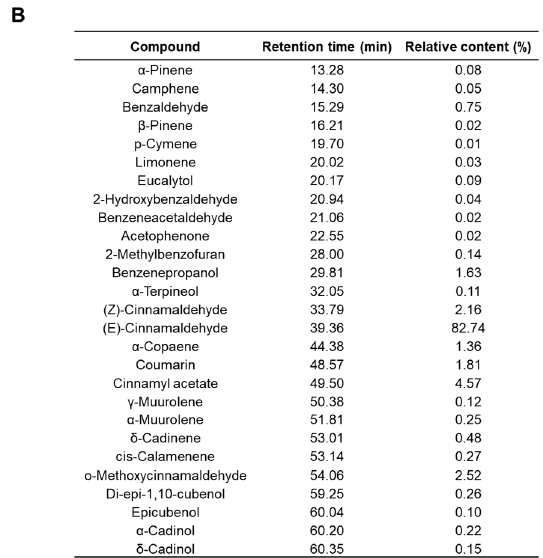
Figure 7. Chemical composition of CIEO. ( A ) GC/MS chromatogram of CIEO. ( B ) Retention time and relative content of detected compounds in CIEO. GC/MS: Gas chromatography/mass spectrometry.